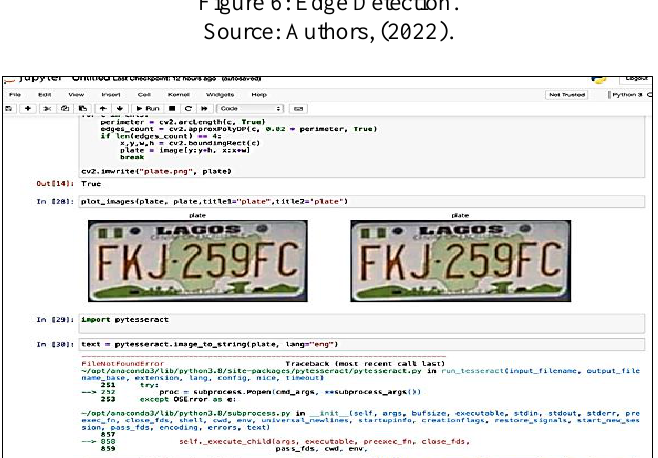
Figure 6: Edge Detection.